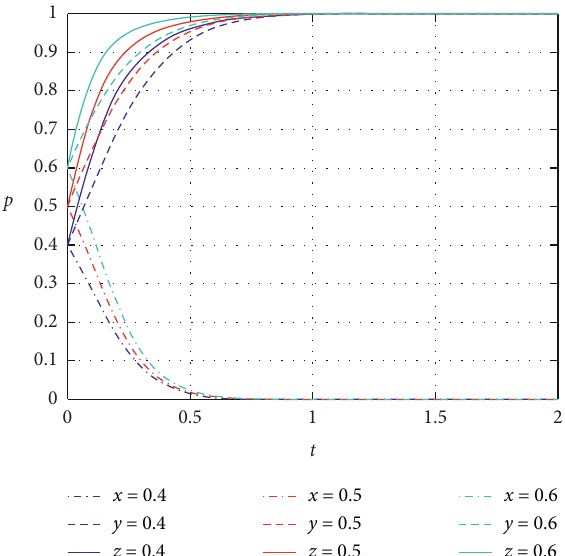
Figure 2: Simultaneous changes of initial willingness to participate x,y, z